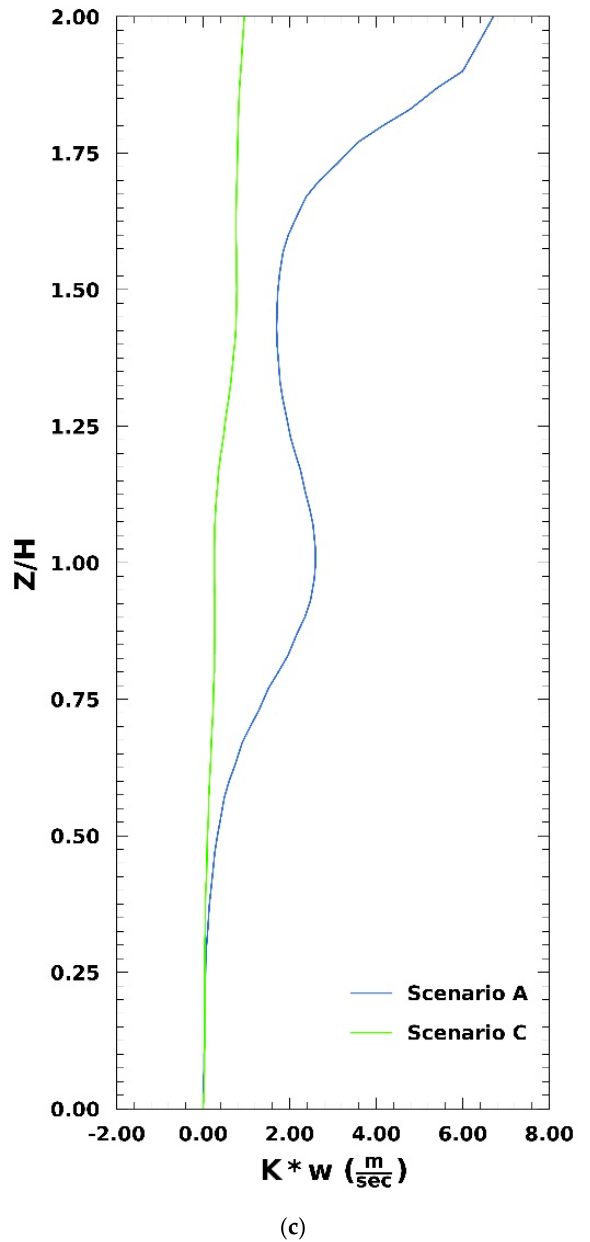
Figure 15. Distribution of the non-dimensional flux concentration at the z − component of the velocity on the symmetry plane for Scenarios A and C at positions ( a ) (X: 7 H, Y: 5.5 H), ( b ) (X: 7.2 H, Y: 5.5 H), and ( c ) (X: 7.4 H, Y: 5.5 H) for height Z that extends from 0 to 2 H.